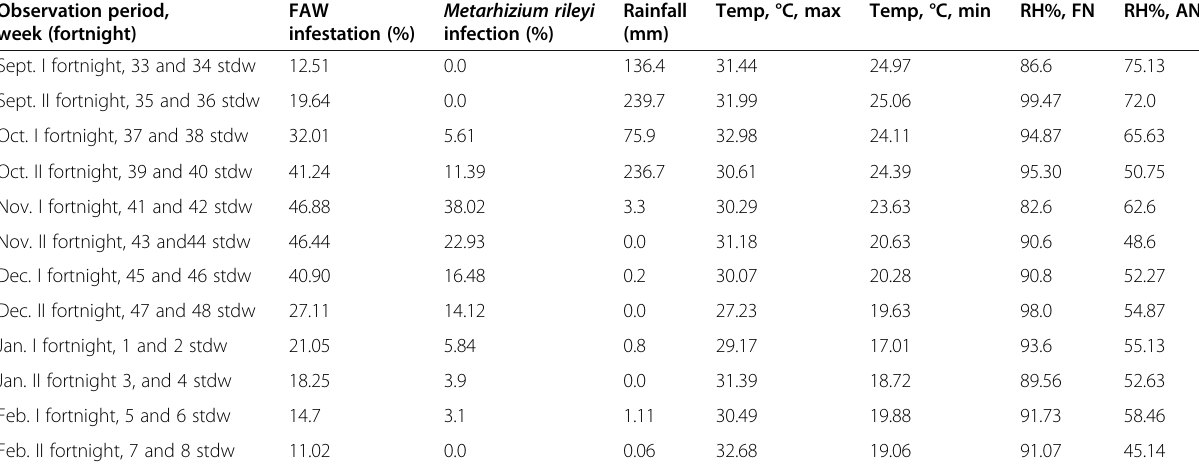
Table 2 Natural incidence of Metarhizium rileyi infection on maize fall armyworm in relation to weather variables during 2019 – 2020 Observation period, week